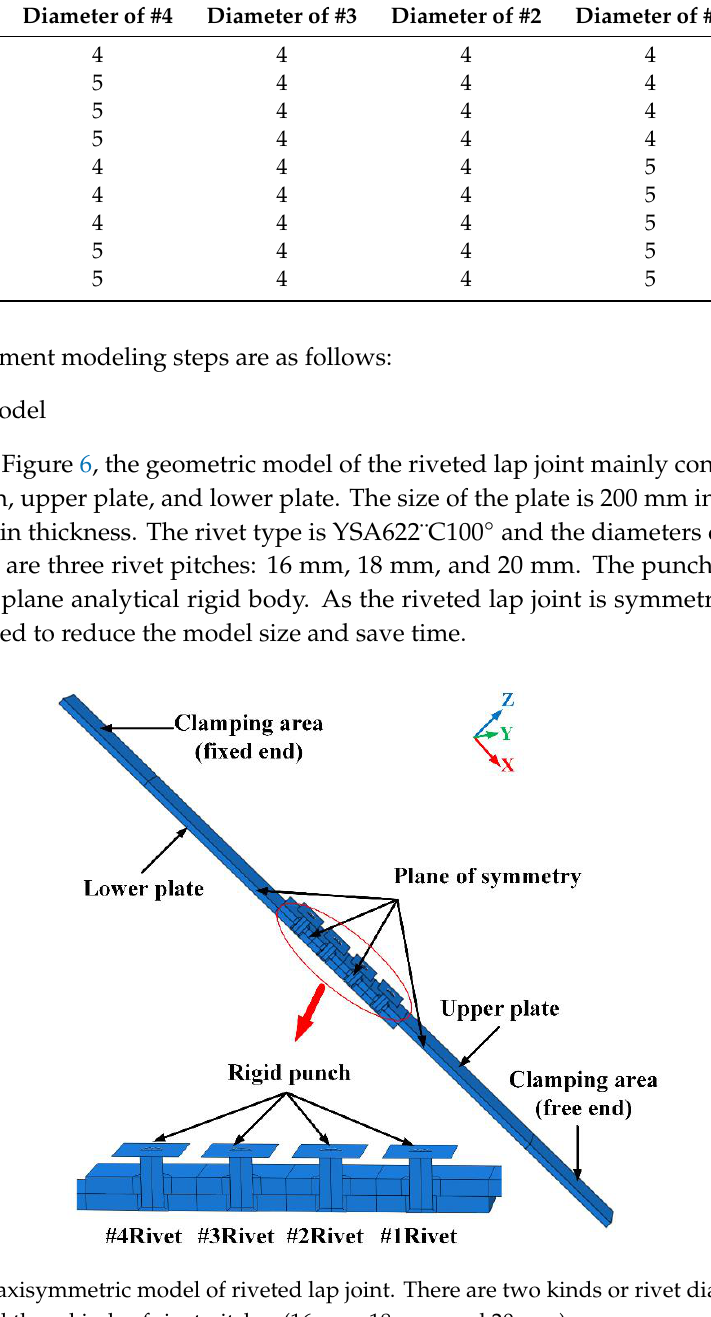
Table 1. The ten groups of riveted lap joints with different rivet diameters and pitches (unit: mm). Rivet Diameter Rivet Diameter Rivet Diameter Group of #4 of #3